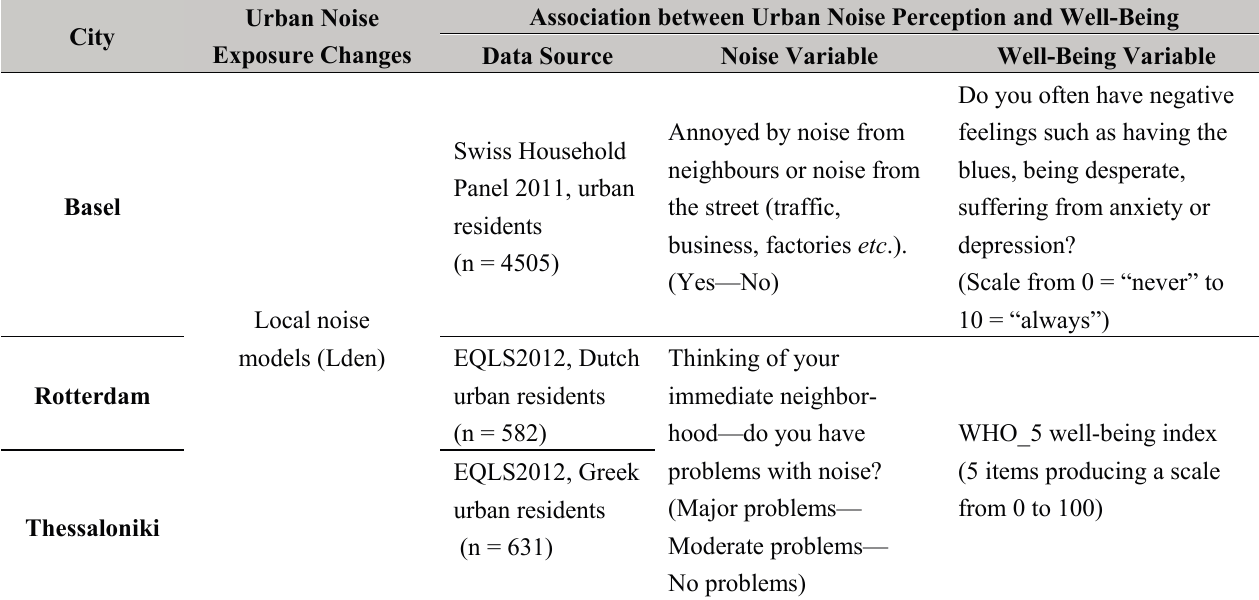
Table 3. Data used for the well-being impact